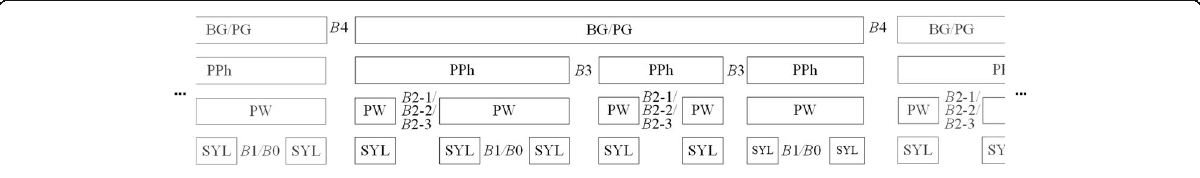
Fig. 1 Hierarchical prosodic model of Mandarin speech used in this study